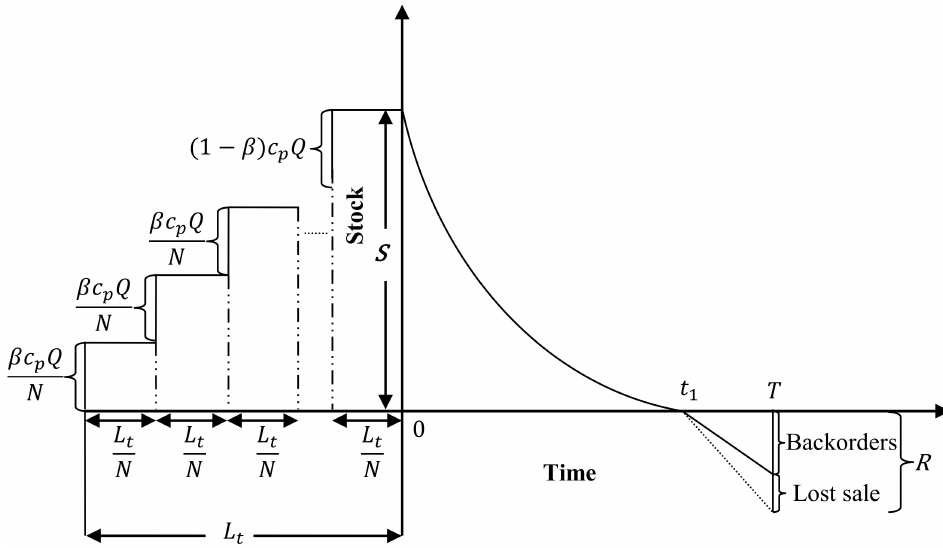
Figure 2. Graphical representation of the proposed inventory model for Case